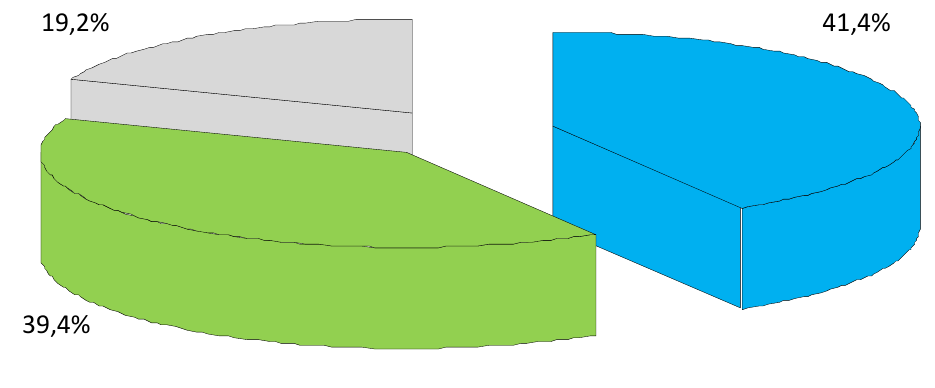
Fig.1. 1st year students’ progressin theoretical disciplines